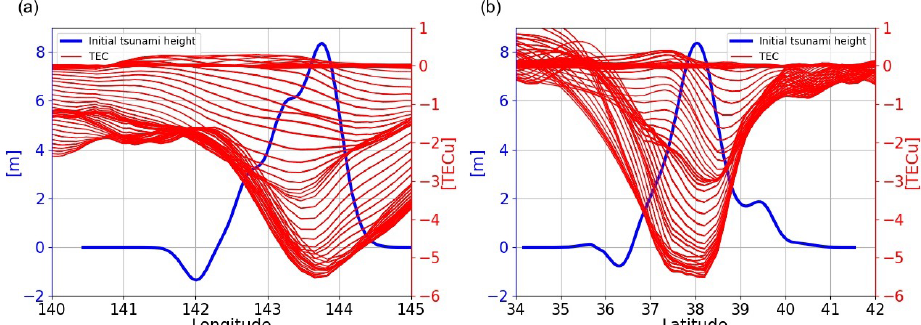
Figure 14. Initial-tsunami height and time series variation of TEC from 05:46:30 to 06:16:30 (UTC). Panel (a) shows the TEC time series when the initial-tsunami height is fixed at the highest latitude, and panel (b) shows the TEC time series when the longitude is fixed. The initial-tsunami height corresponds to the scale on the left axis (blue), and the TEC value corresponds to the scale on the right